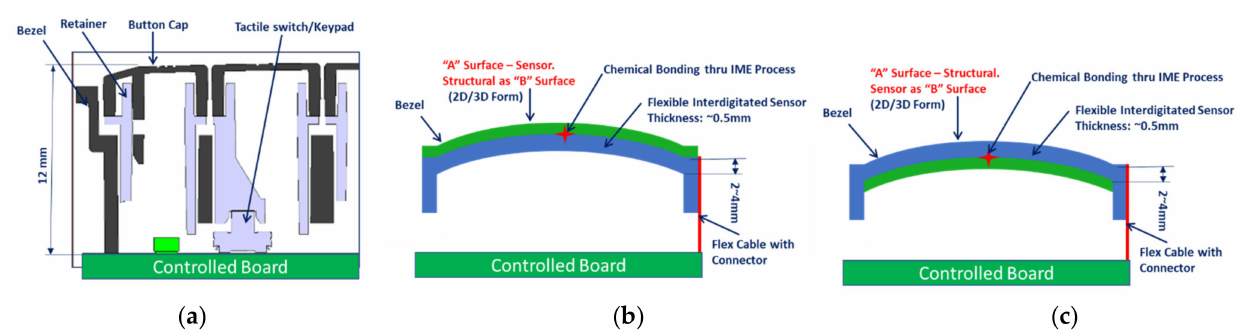
Figure 2. Configuration of IVI Bezel ( a ) Current Design ( b ) Proposed—Direct Touch ( c ) In-Direct Touch.